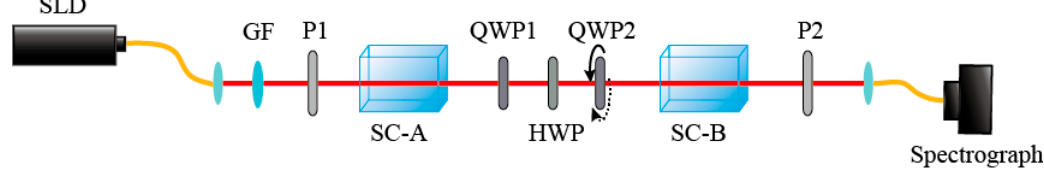
Figure 1. The schematic diagram of the weak measurement system.